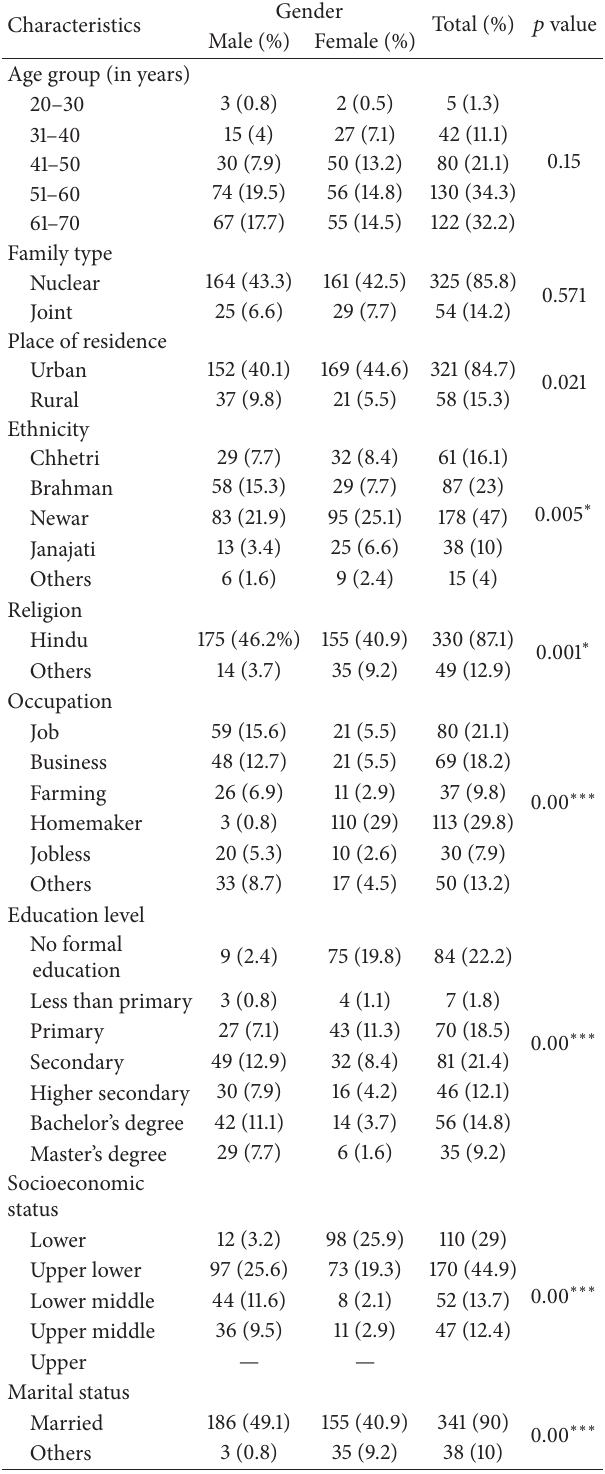
Table 1: Sociodemographic characteristics of respondents by gen- der.